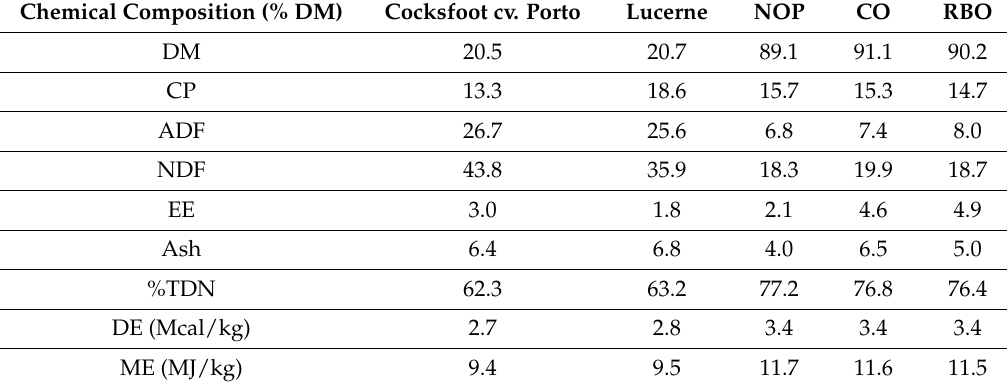
Table 1. Proximate analysis of supplementary feed and pasture.